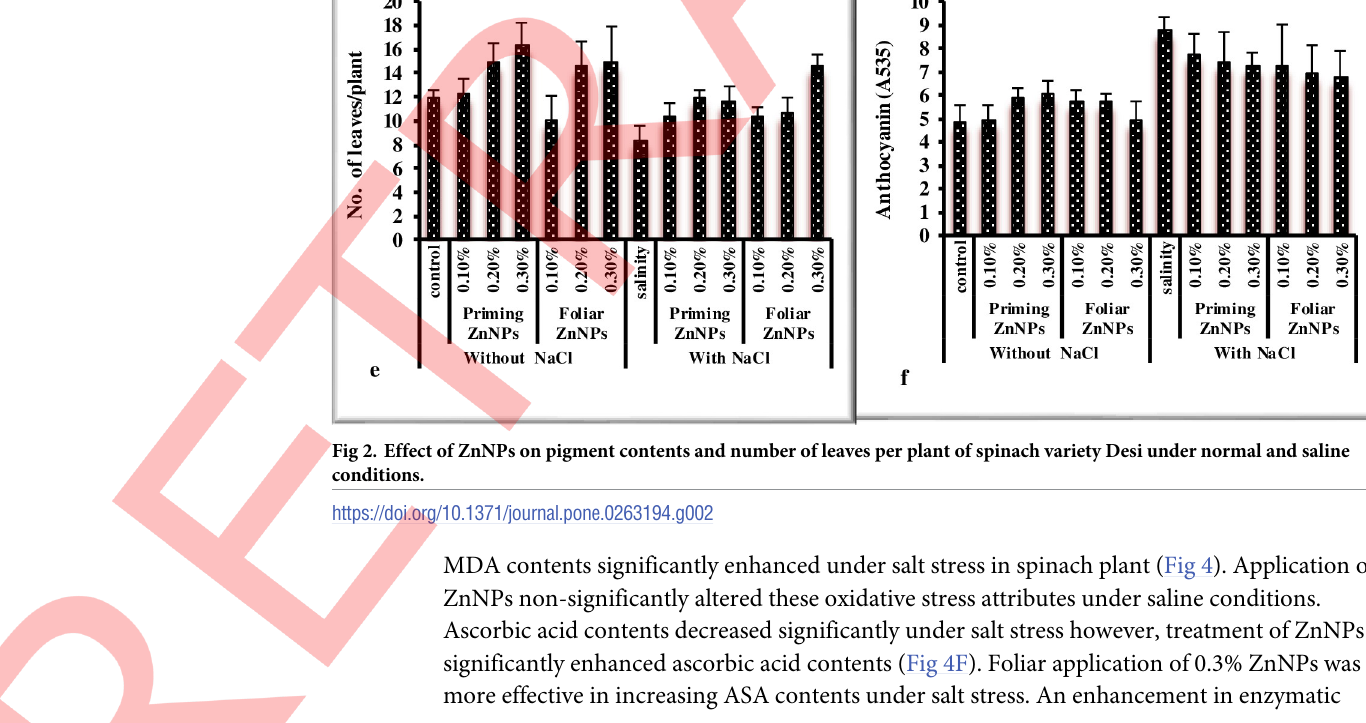
PLOS ONE | https://doi.org/10.1371/journal.pone.0263194 February 22,